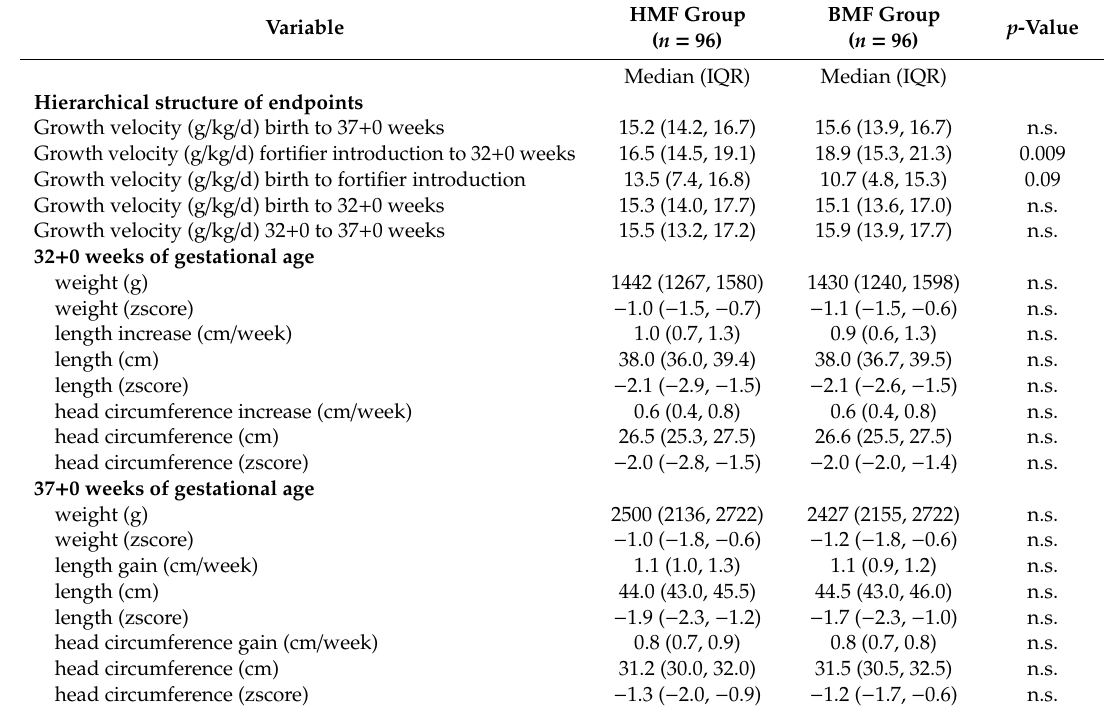
Table 3. Growth velocities and anthropometry of the study